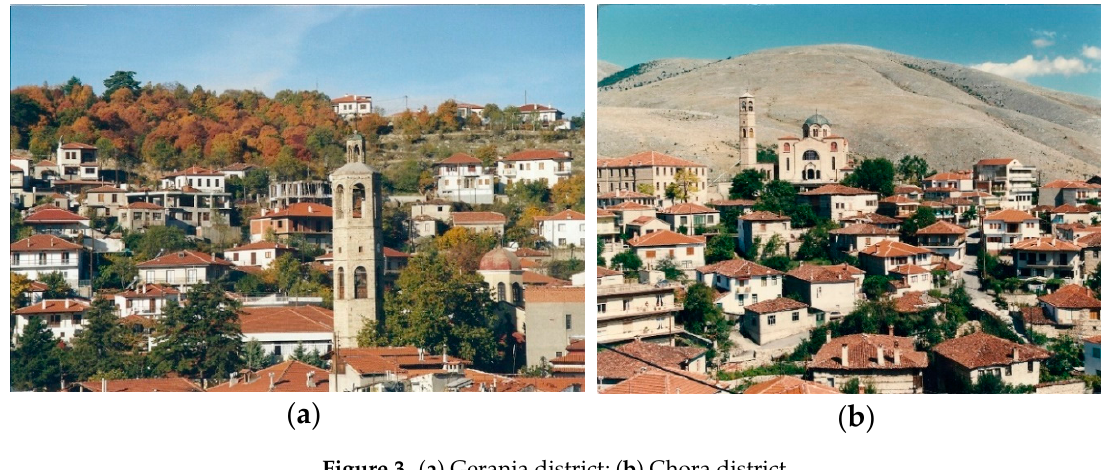
Figure 3. ( a ) Gerania district; ( b ) Chora district.